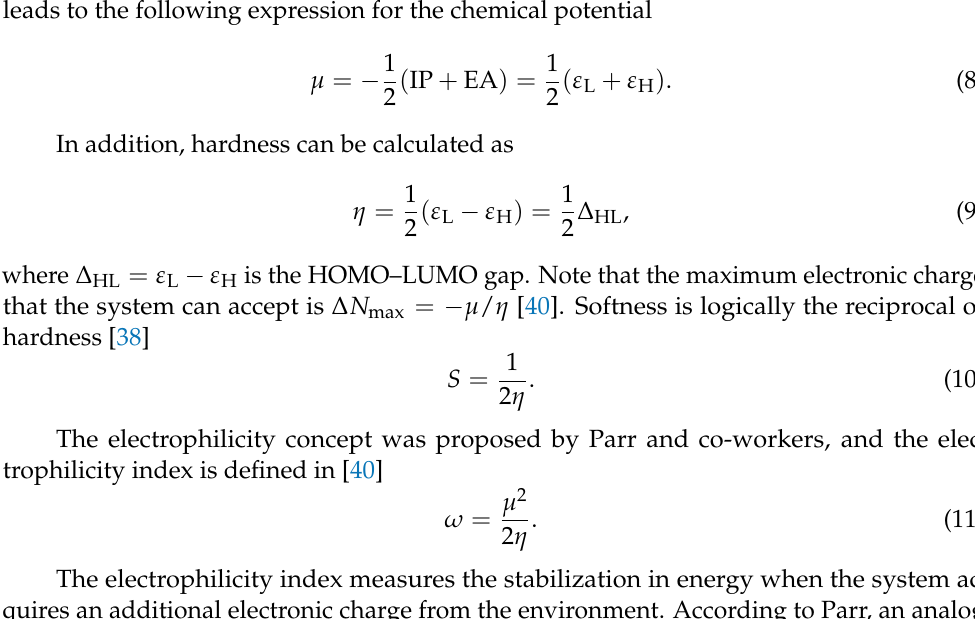
Figure 8. The electronegativity χ versus the number of Si-/Ge-atoms n in the Si n CL-20/Ge n CL-20 molecules for the most thermodynamically stable configurations obtained at the DFT/B3LYP/6- 311(d,p) level of theory.